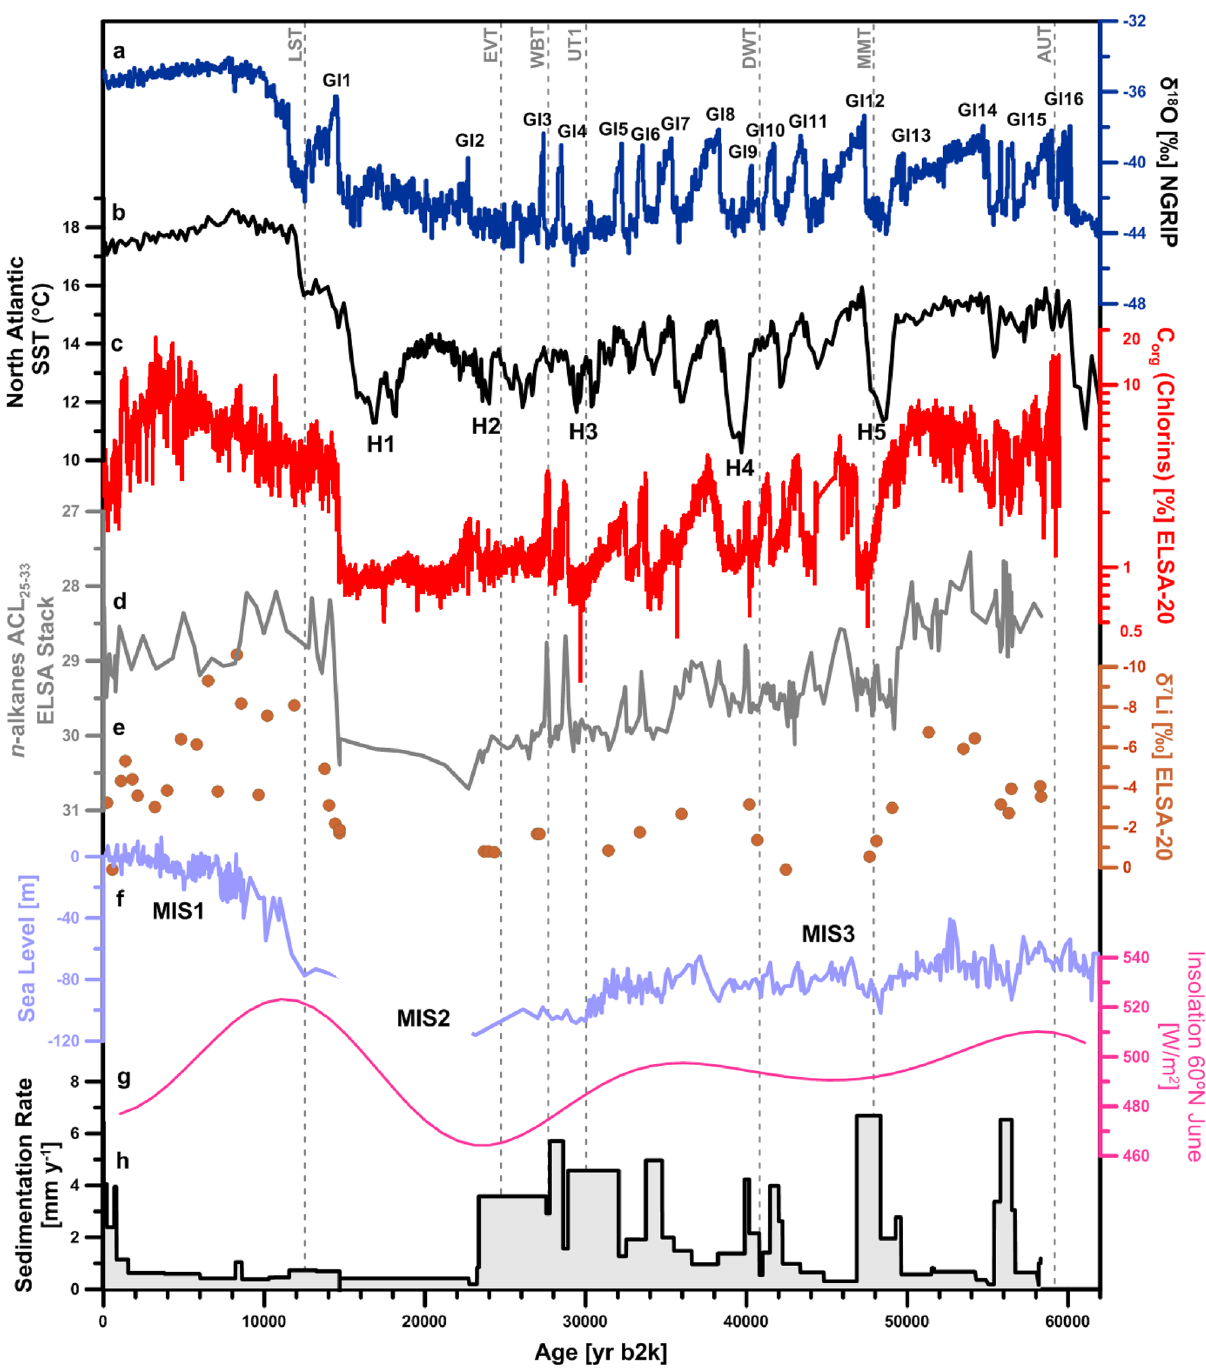
Figure 3. Selected global climate records in comparison to sedimentological and tephra records of the ELSA- 20-Stack. Insolation 81 , sea level 16 , North Atlantic Sea surface temperatures 21 , NGRIP δ 18 O 18 , Eifel Tephra 45